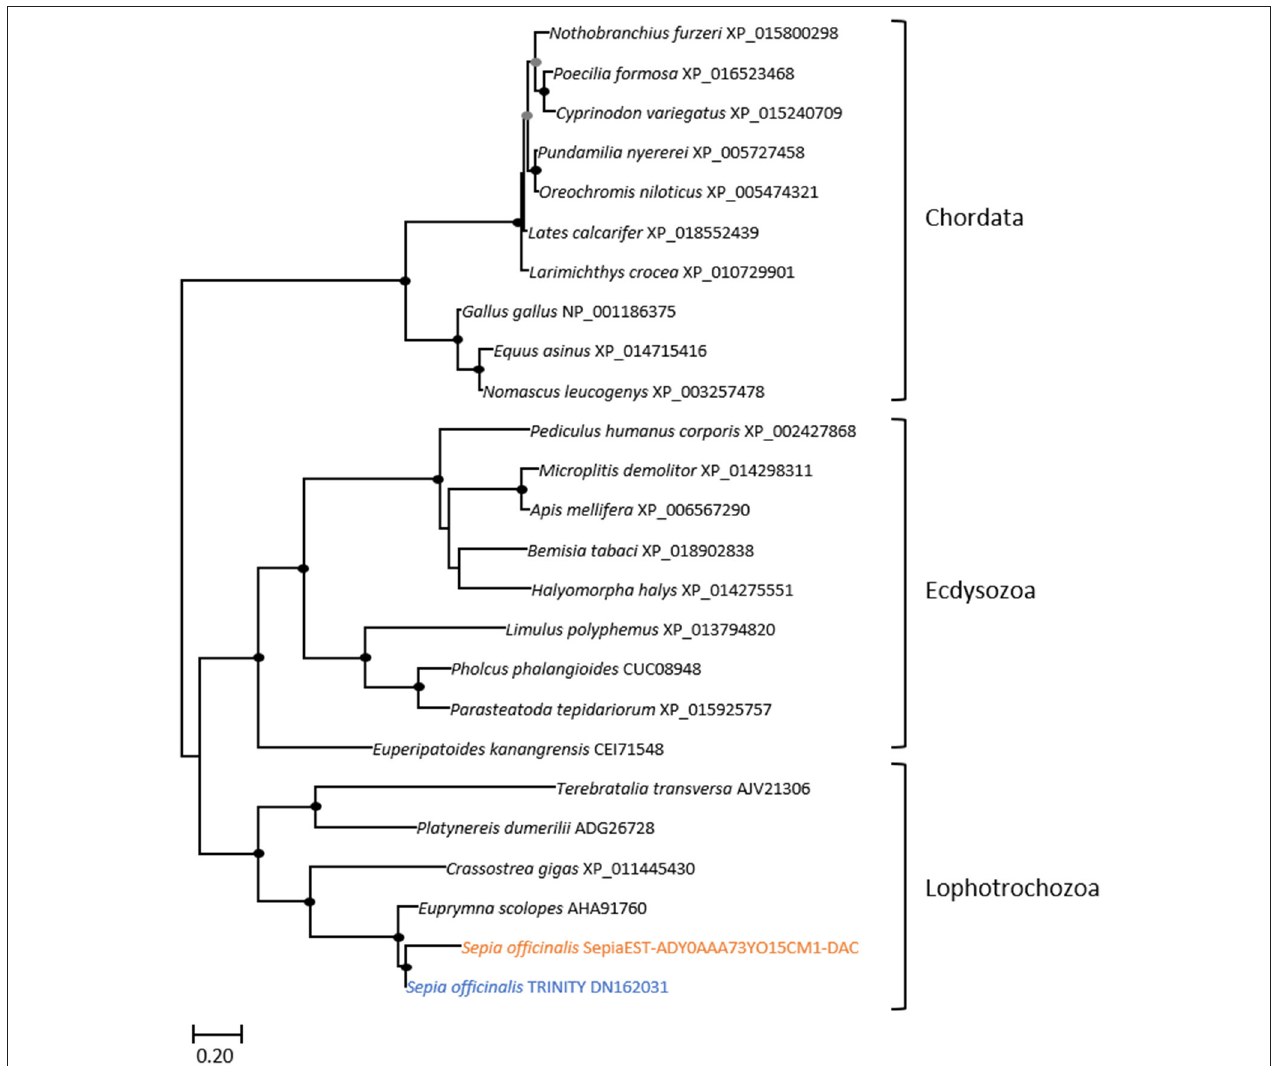
FIGURE 5 | Diversity of dachshund. Maximum-likelihood tree based on 170 aligned amino-acids. The specific S. officinalis EST is shown in orange, and the S. officinalis contig/gene is shown in blue. The EST and the contig protein sequences are slightly divergent in the N-terminal part of the sequences, probably because of EST sequence errors but importantly only the central and conserved region was used to generate the probe for in situ hybridization. For the color code used for the bootstraps refer to Figure 3